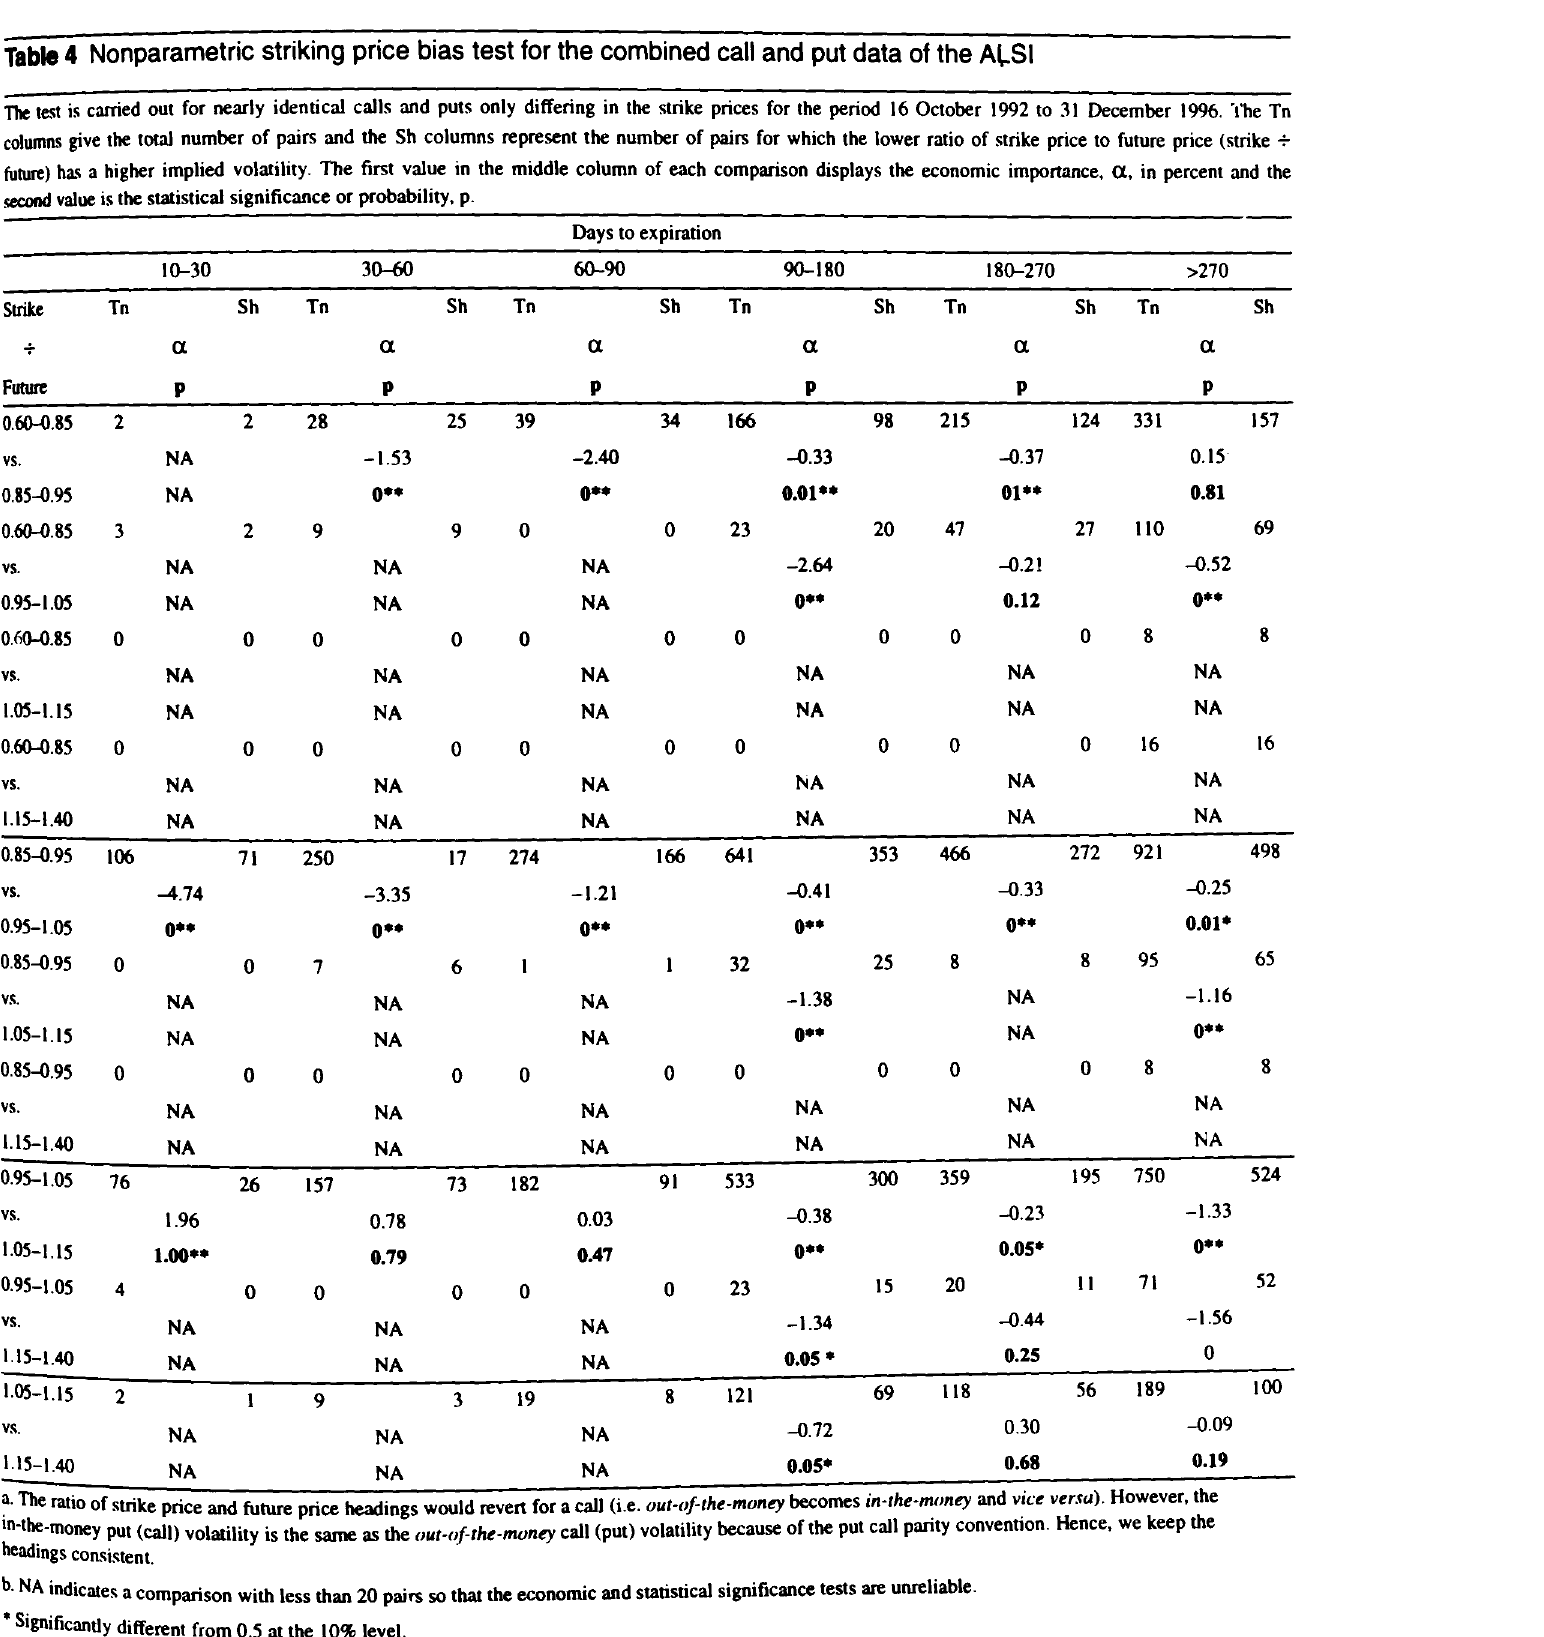
Table 4 Nonparametric striking price bias test for the combined call and put data of the Al,..SI The test is carried out for nearly identical calls and puts only differing in the strike prices for the period 16 October 1992 to 31 December 1996. '!'he Tn columns give the total number of pairs and the Sh columns represent the number of pairs for which the lower ratio of strike price to future price (strike + future) ha~ a higher implied volatility. The first value in the middle column of each comparison displays the economic importance, a, in percent and the second value is the statistical significance or probability,